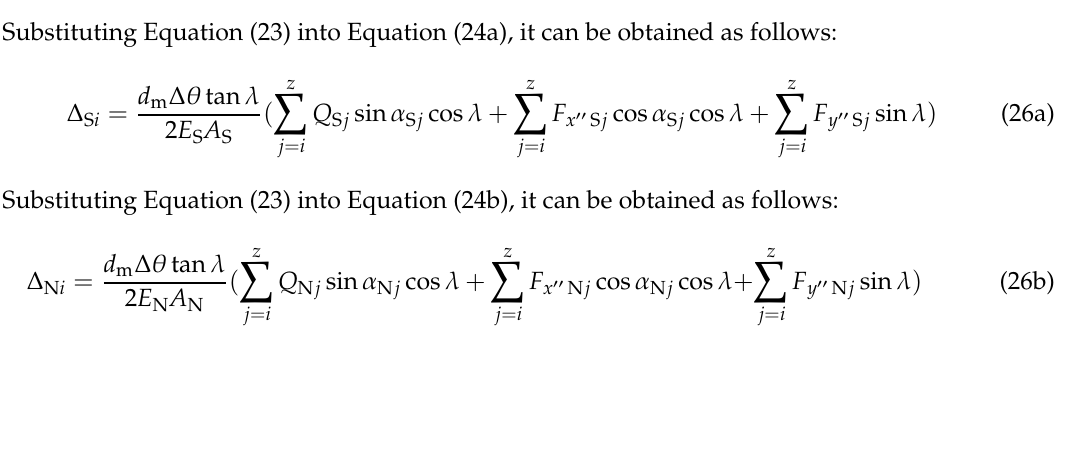
Figure 5. Contact deformations of two adjacent balls in the raceway.